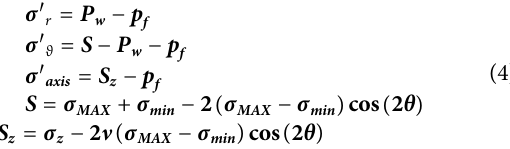
Frontiers in Earth Science |